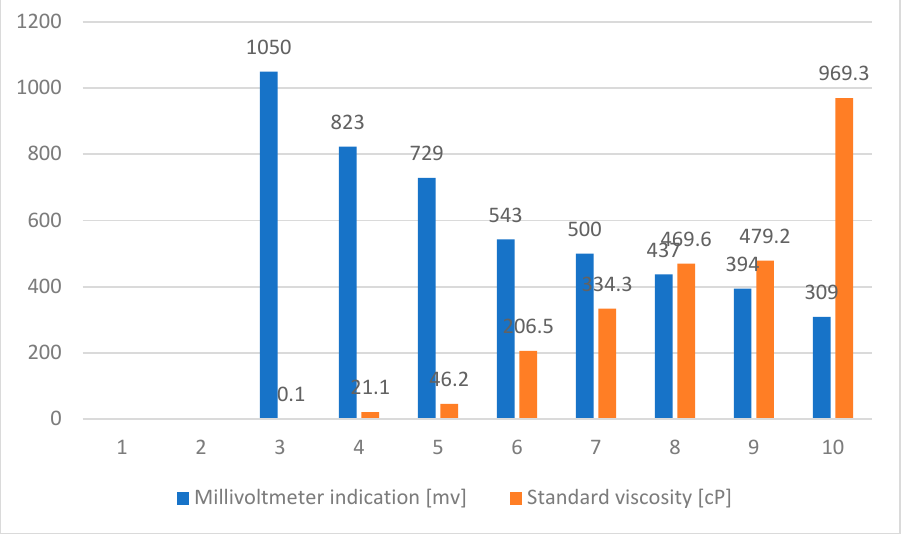
Table 3. Viscosity values measured and given by the standard.